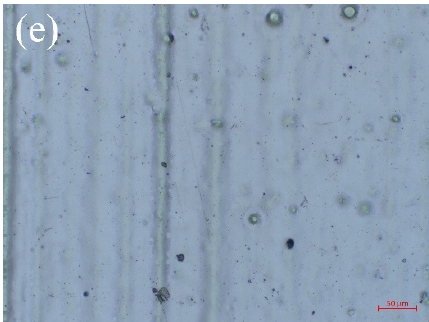
Figure 2. Surface morphology of IN718 alloy: ( a ) original; under IPIB with current density of 100 A/cm 2 , ( b ) 1 pulse; ( c ) 5 pulses; ( d ) 10 pulses; ( e ) 20 pulses. The scale mark on the lower right corner stands for 50 μ m.